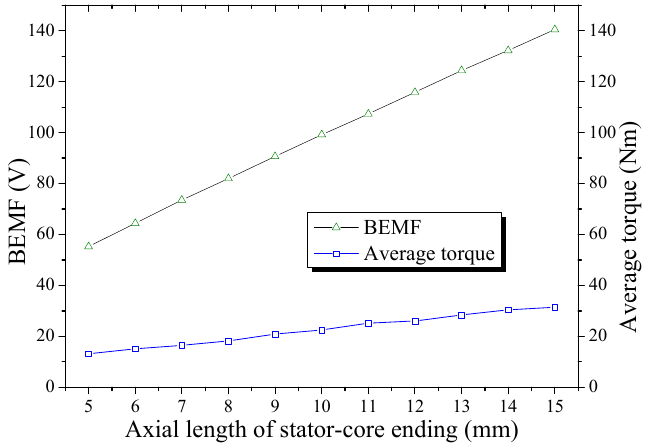
Figure 15. Variation of BEMF and average torque versus axial length of stator-core ending.